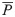
Robustness, evolvability, noise and expression levels for genotypes that are robust and evolvable.The relationships between sensitivity-based robustness, evolvability computed using 1-mutant neighbors, noise and gene expression levels in circuit I, when only monostable genotypes are considered. Genotypes from the set of genotypes characterized by high robustness and evolvability ((E × R) > 0.1, cf. Figure B in S1 File) are drawn in red to compare their positions with respect to different measure combinations. (a): The robustness-evolvability relationship of the G-P mapping. (b): Scaled intrinsic noise versus robustness. (c): The relationship between scaled intrinsic noise and evolvability. (d): Gene expression levels at steady state (P¯) plotted against scaled intrinsic noise.